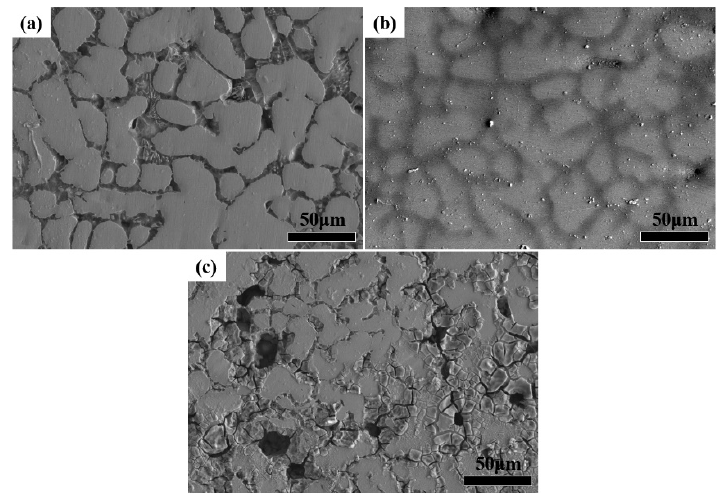
Figure 4. Surface morphologies of high entropy alloys after electrochemical etching: ( a ) TiZrTaNb alloy; ( b ) TiZrTaNbMo alloy; ( c ) TiZrTaNbSn alloy.